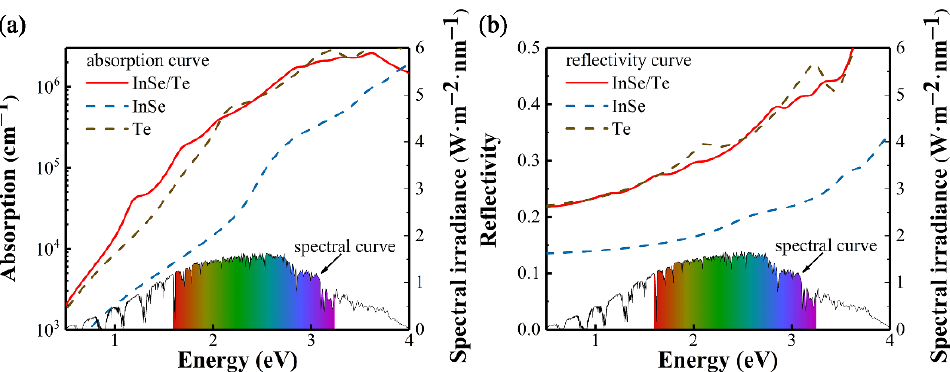
Figure 5. ( a ) Calculated optical absorption coefficients as well as ( b ) the reflectivity of InSe/Te heterostructure, InSe monolayer, and tellurene. Curve in bottom indicates reference solar spectral irradiance, and colorful background represents visible light area [55].